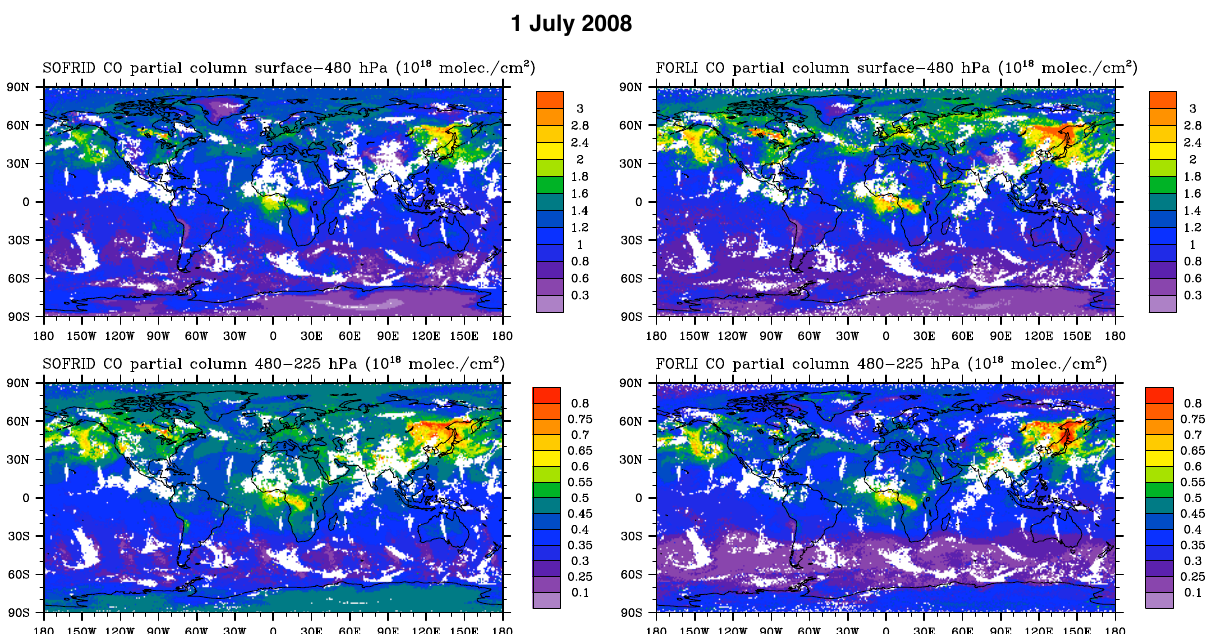
Fig. 4. Global plots of CO partial columns (surface–480hPa and 480–225hPa) retrieved with SOFRID (left panels) and FORLI (right panels) for 1 January 2008 (top panels) and 1 July 2008 (bottom panels), representing the global CO distribution during two composite seasons. Shown here are daily means (average of the daytime and nighttime observations). The pixels are binned on a 1 ◦ × 1 ◦